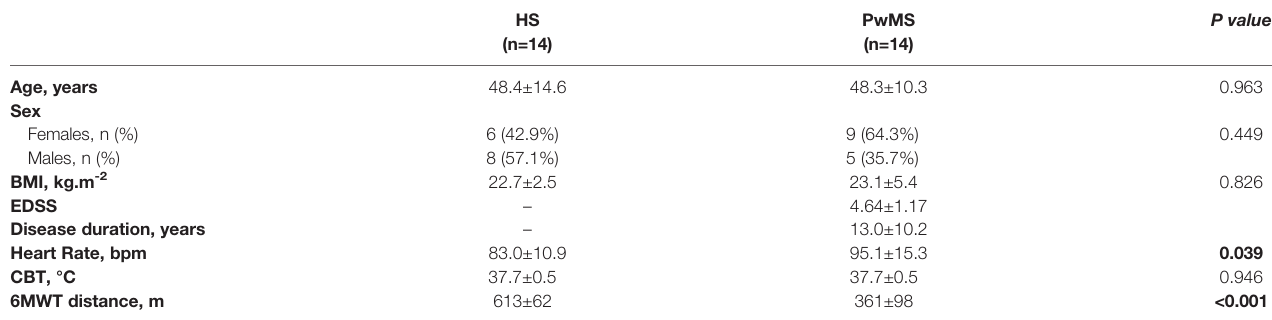
TABLE 1 | Baseline anthropometric, demographic and clinical characteristics (m±SD) of the enrolled subjects, divided for group.